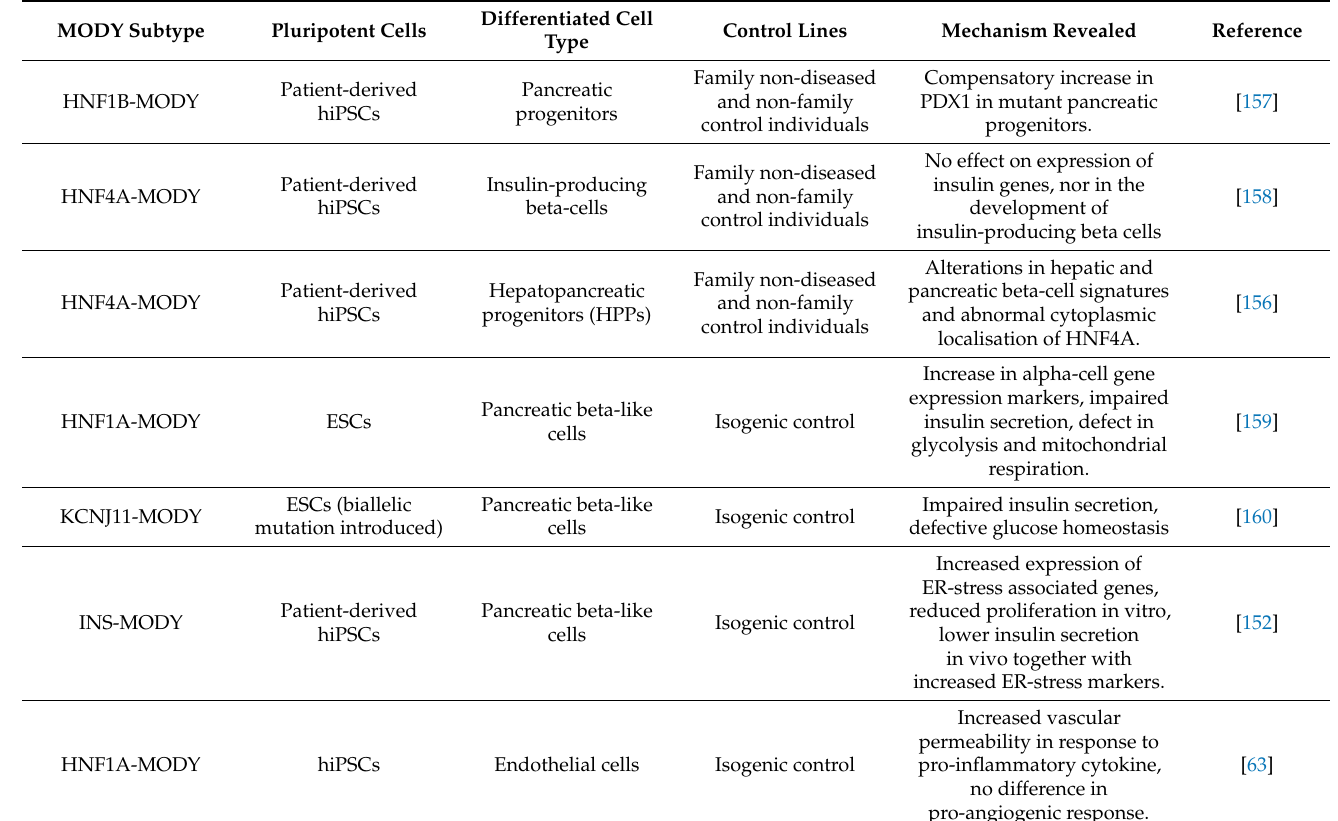
Table 2. Summary of studies using pluripotent stem cells as disease modelling tool, hiPSCs—human induced pluripotent stem cells, ESCs—embryonic stem cells, ER—endoplasmic